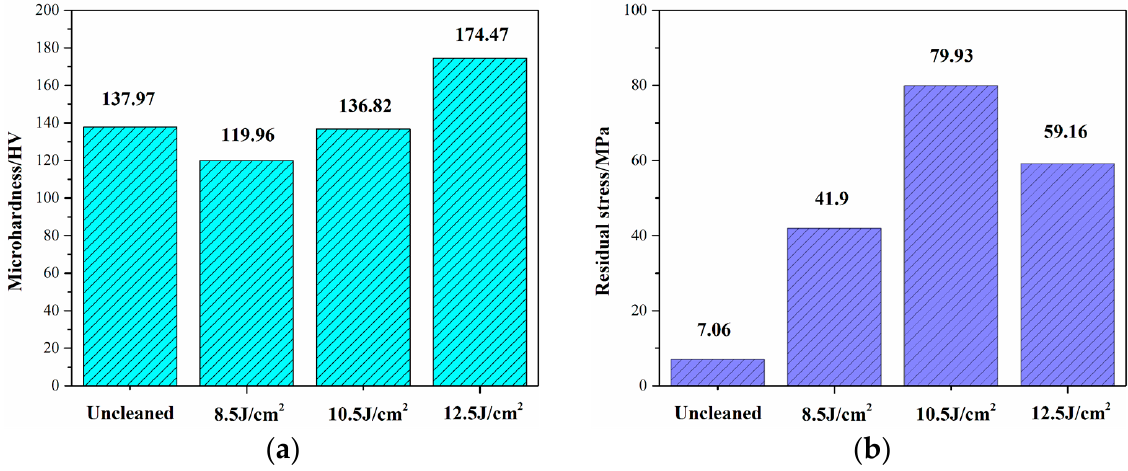
Figure 6. The friction coefficient of each sample under different loading energy densities: ( a ) friction coefficient; ( b ) average friction coefficient.